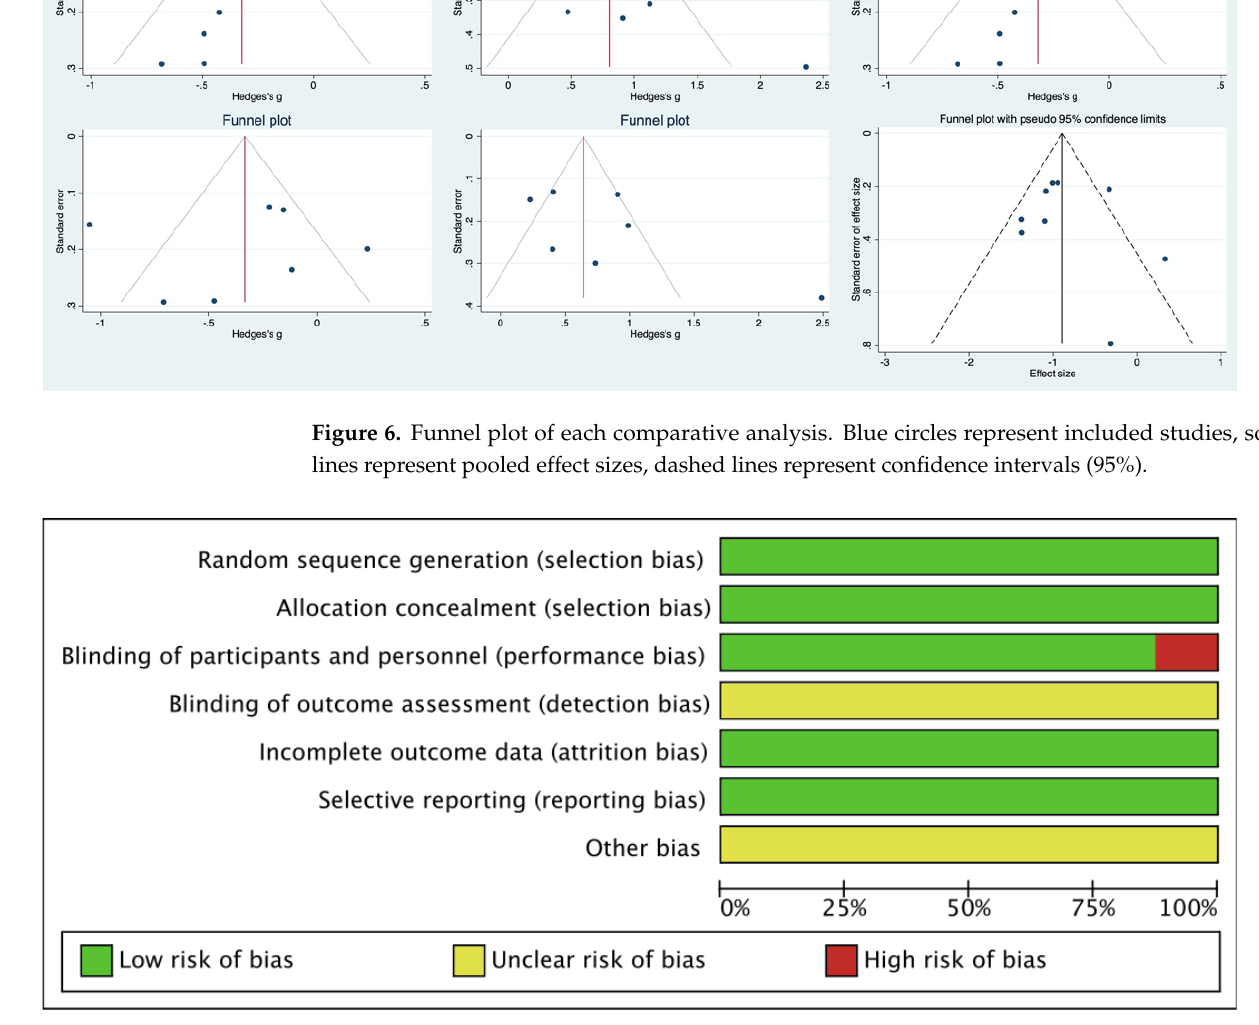
Figure 7. risk of bias.